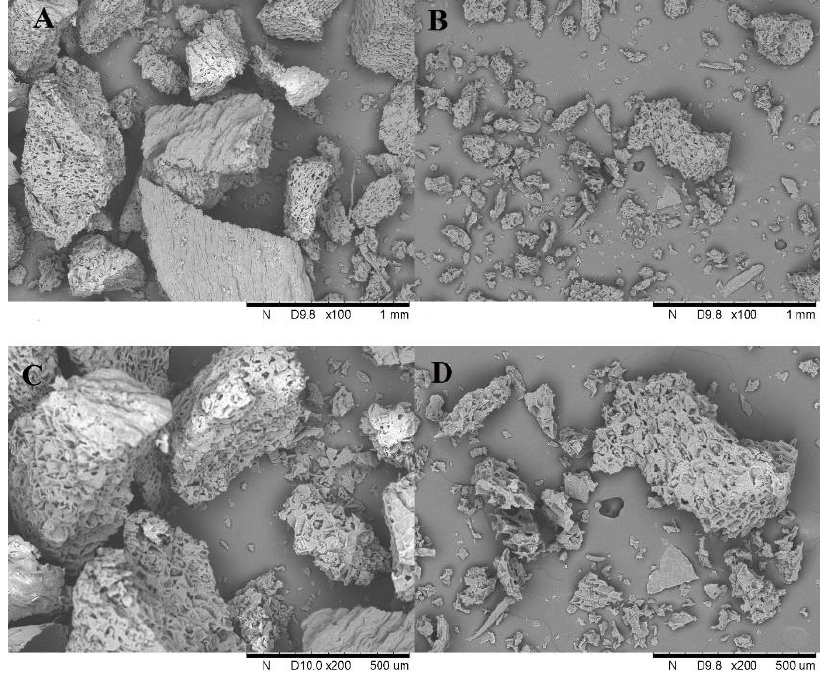
Figure 3. Scanning electron microphotographs of ( A , C ) liquid lipase Novozym 51032 immobilized on coffee grounds ( × 100, × 200) and ( B , D ) coffee grounds ( × 100, × 200).